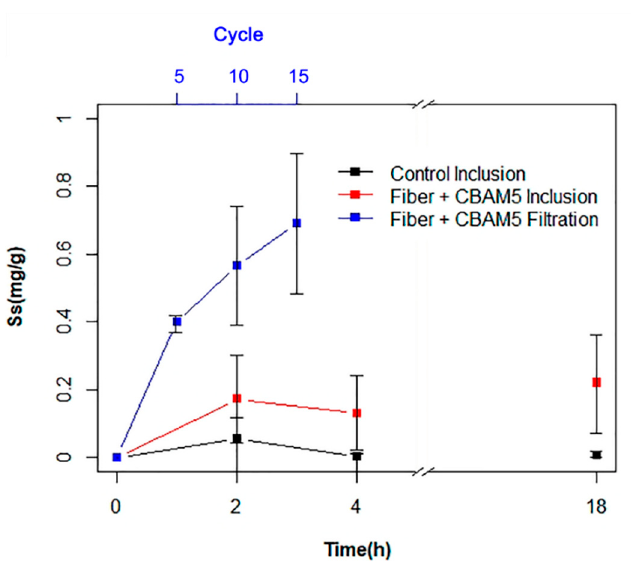
Figure 4. Gold (10 ppm) biosorption assays with L. sphaericus CBAM5 immobilized in PCL fibrous mats (Fiber + CBAM5) and the fiber without cells (Control) by inclusion in synthetic water and using a filtration system.